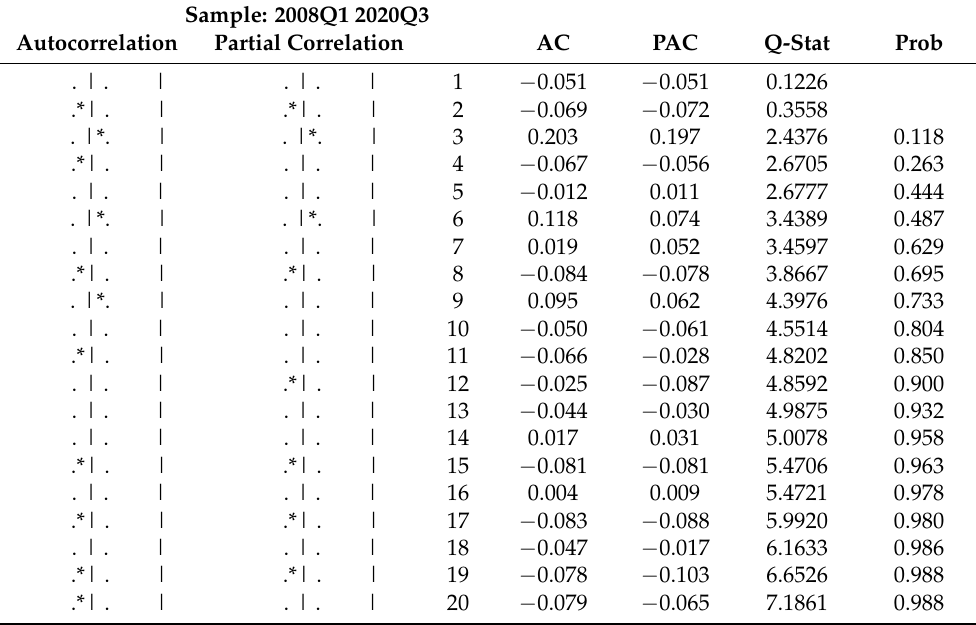
Table 8. Ljung–Box statistics.